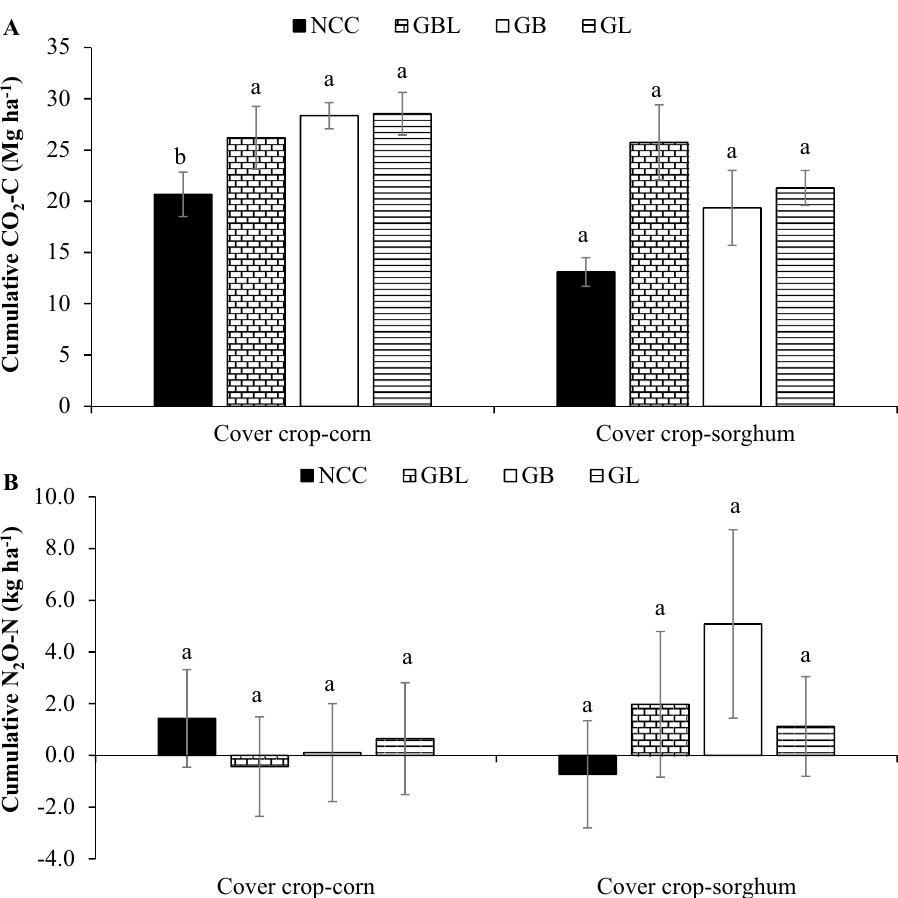
Figure 2. Cumulative CO 2 -C ( A ) and N 2 O-N ( B ) emissions in forage corn and forage sorghum across crop growing phases (cover crops and cash crop) and years (2018/19 and 2019/20). For each rotation, bars with a different letter indicate statistical significance between cover crop rotations at p ≤ 0.05 per protected LSD test. Error bars represent the standard error of the mean. NCC no cover crops control, GBL grasses, brassicas, and legumes mixture, GB grasses and brassicas mixture, GL grasses and legumes